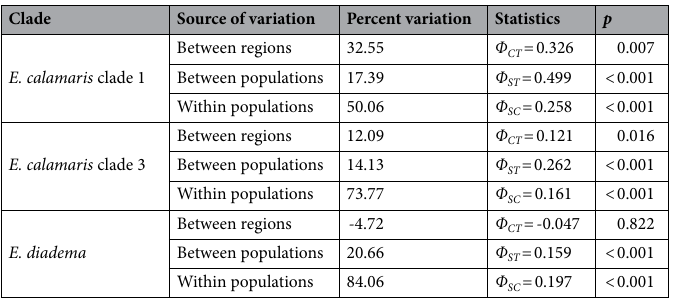
Table 2. AMOVA based on mtDNA Tamura and Nei 31 distances comparing differentiation between and within geographic regions (Indian Ocean, western Pacific Ocean, central Pacific Ocean, Hawaiian Archipelago, tropical eastern Pacific) in each clade of Echinothrix .